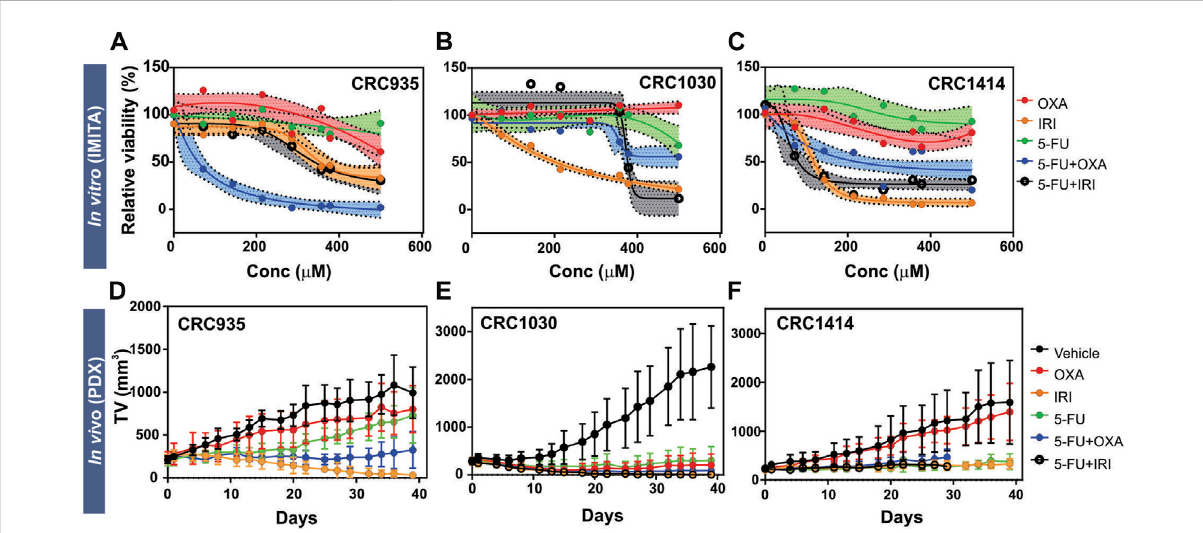
FIGURE 4 Treatmentresponsesof5SOCchemotherapiesfor3CRC patients(CRC935, CRC1030,andCRC1414)obtained from invitro (IMITA)and invivo (PDX)models. (A – C) Dose-responsecurvesobtained after3 daysofdrugtreatmentintheIMITA devices.Fitteddose-responsecurveobtained using n > 3 devices with shaded area representing 95% con fi dence interval. Two-way ANOVA analysis yielded p = 0.002 for CRC935, p < 0.0001 for CRC1030 and CRC1414. (D – F) Tumour growth rates in PDX models. 5-Fluorouracil and IRI were administered at a dosage of 50 mg kg − 1 . OXA was administered at a dosage of 5 mg kg − 1 . 5-FU + OXA and 5-FU + IRI were prepared with same concentrations. Data are averages of n > 3 animals with ± standard